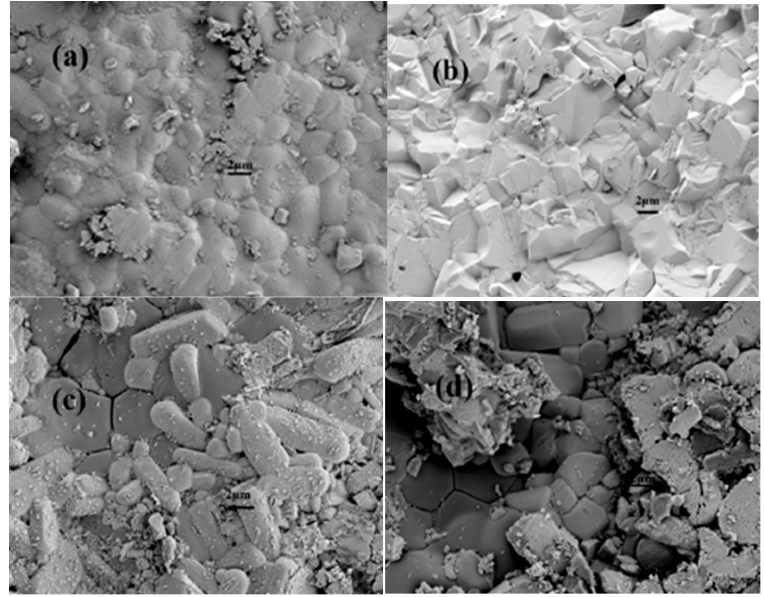
Figure 2. The external ( a , c ) and cross-sectional ( b , d ) SEM photos of BaCe 0.9 Er 0.1 O 3 −α (1550 °C) and BaCe 0.9 Er 0.1 O 3 −α –K 2 SO 4 –BaSO 4 .